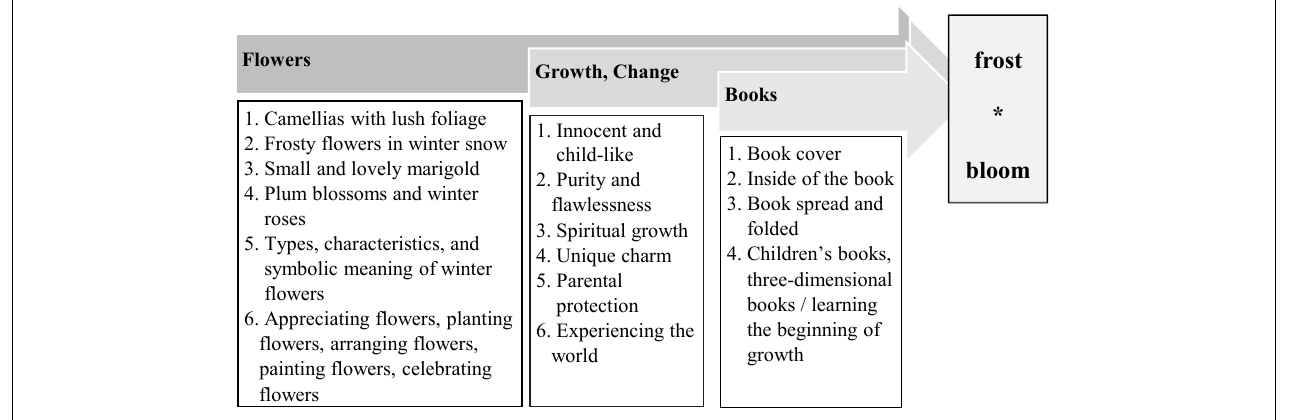
FIGURE 6 | Flow chart for the development of student A’s initial theme.